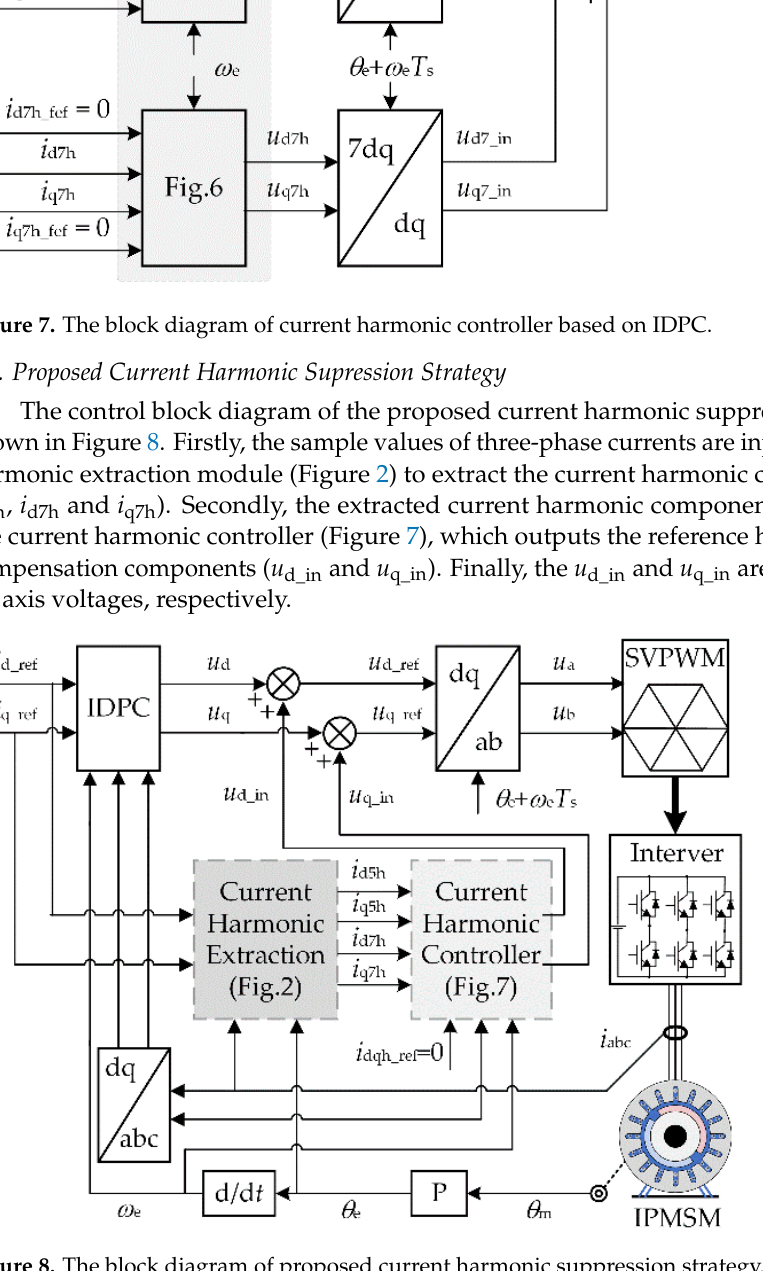
(27) Figure 6. The block diagram of IDPC of the k th control cycle in the 7th synchronous rotating frame. 3.3.3. Improved Current Harmonic Controller